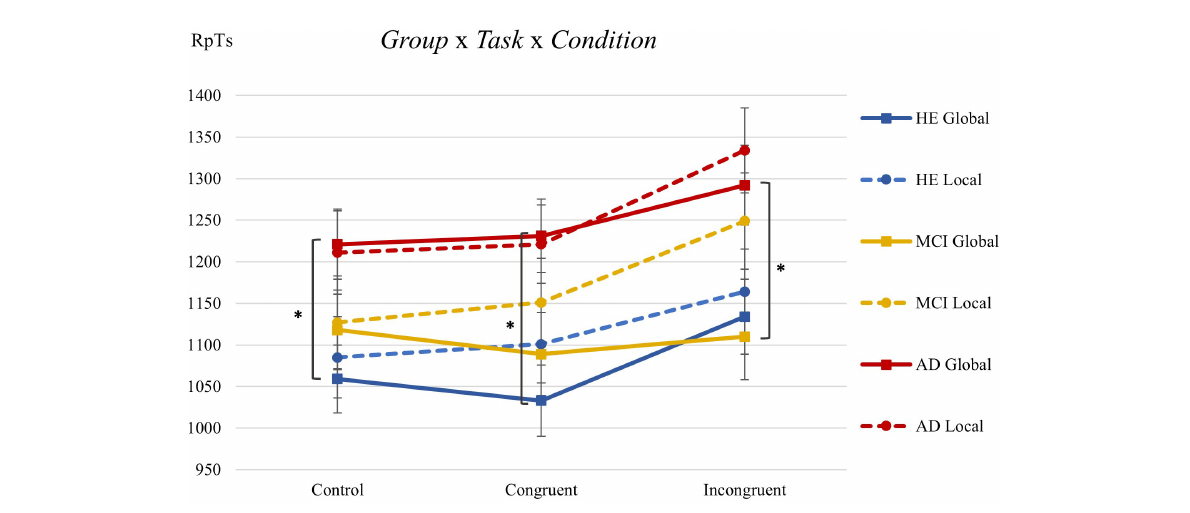
FIGURE2 Estimated mean values (and standard error) of RpTs (in ms) for each group, task, and congruency in the Navon task. ∗ Significant differences from pairwise comparisons for the factors Group × Task × Congruency . Group: HE, healthy elderly; MCI, mild cognitive impairment; and AD, Alzheimer’s disease. Task : global and local. Congruency : control, congruent, and incongruent.